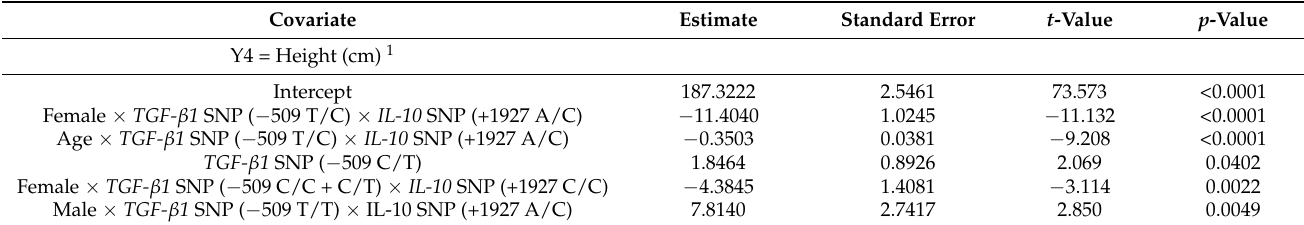
Table 6. Multivariate analyses of the predictors of height using MLR